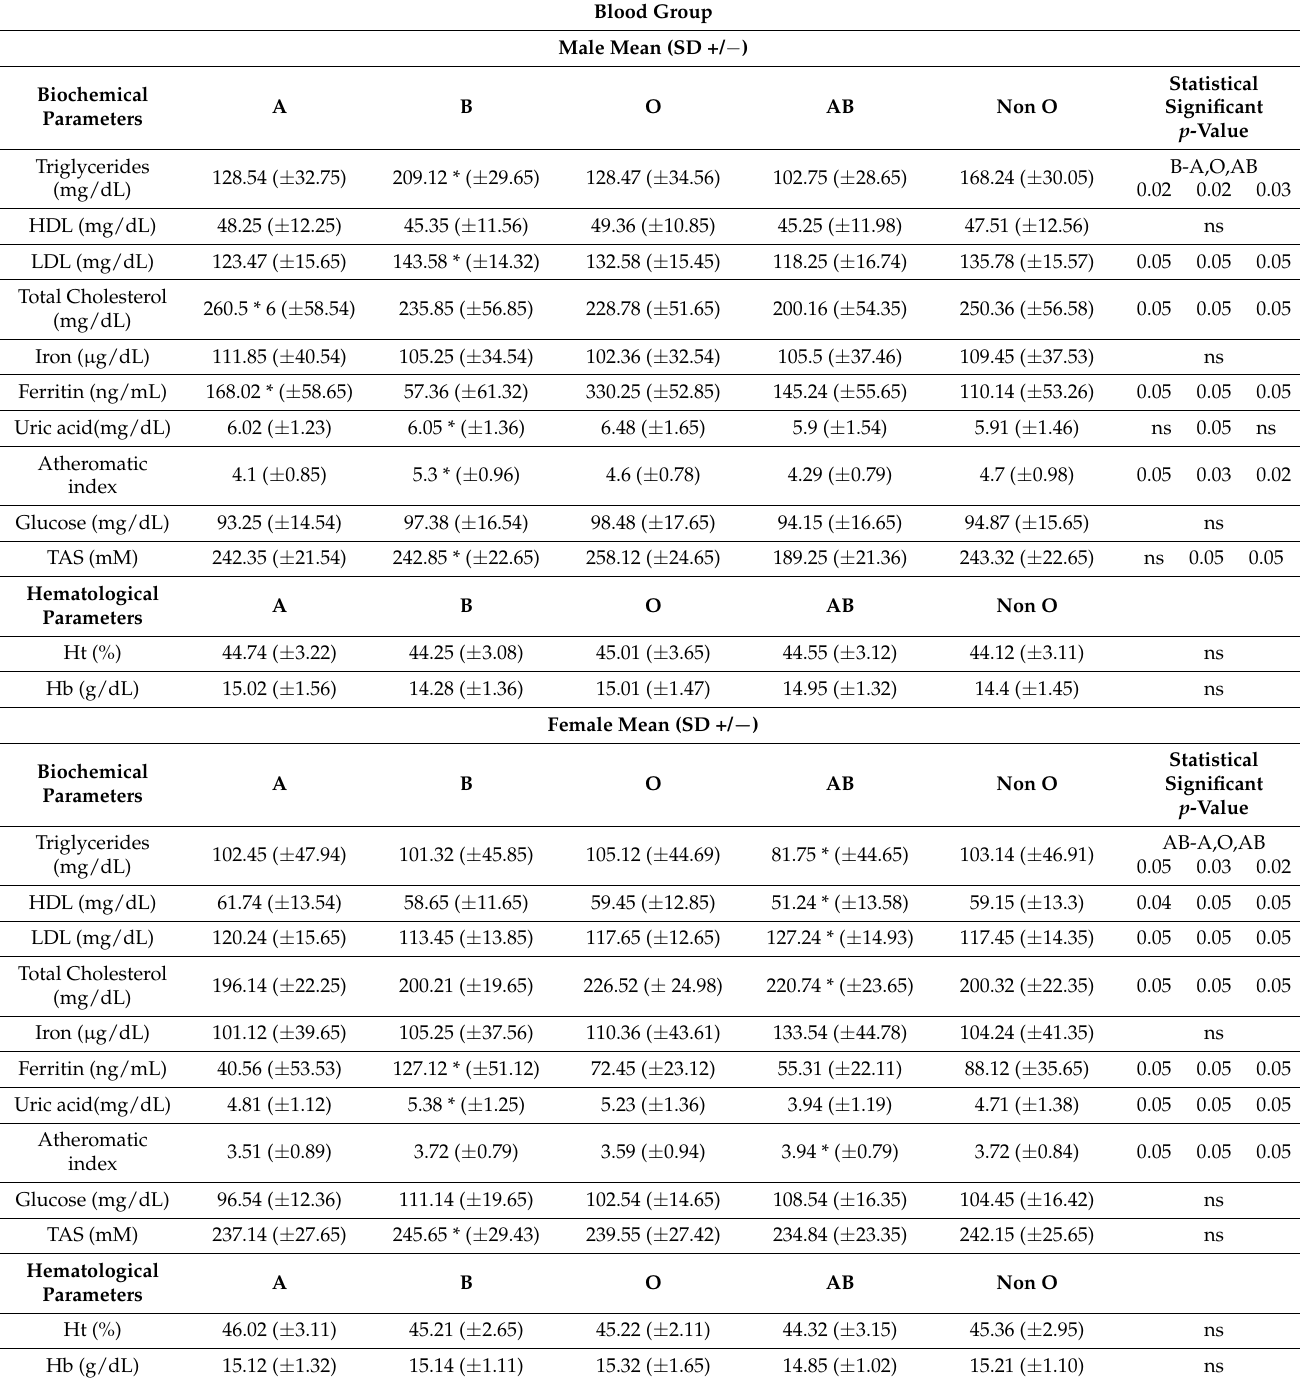
Table 5. Biochemical and hematological parameters in male and female separately related to ABO blood